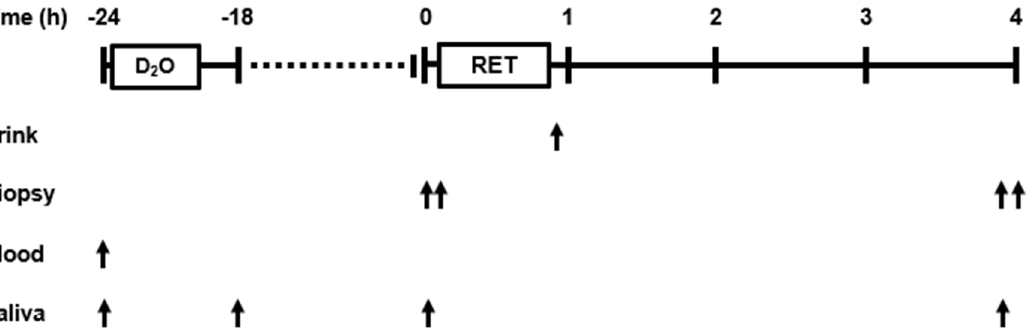
Figure 2. Study design. D 2 O, deuterium oxide bolus (5 mL · kg − 1 ingested at 2.5 mL · kg − 1 · h − 1 ); RET, unilateral knee extensor resistance exercise training; post-exercise beverage was either 0.33 g · kg − 1 fava bean protein or nonessential amino acids. Arrows indicate time of occurrence.